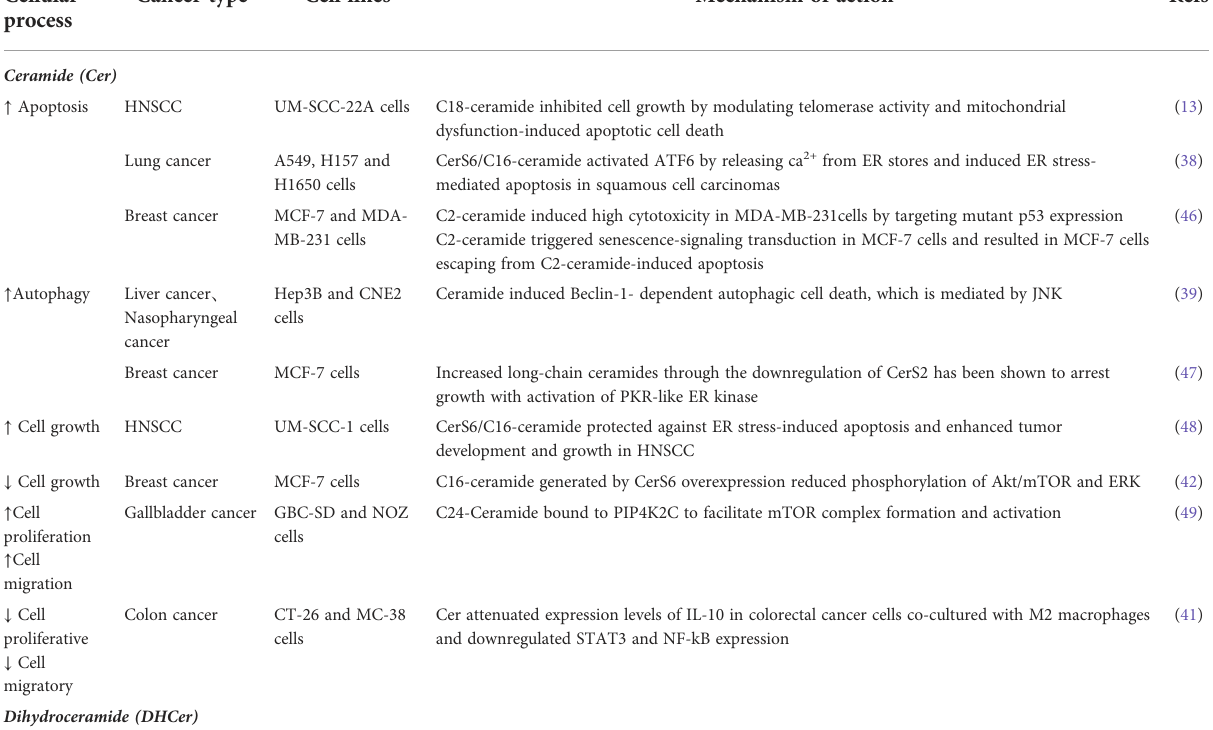
TABLE 2 Sphingolipid metabolites and enzymes and their key cellular functions in cancer. Cellular